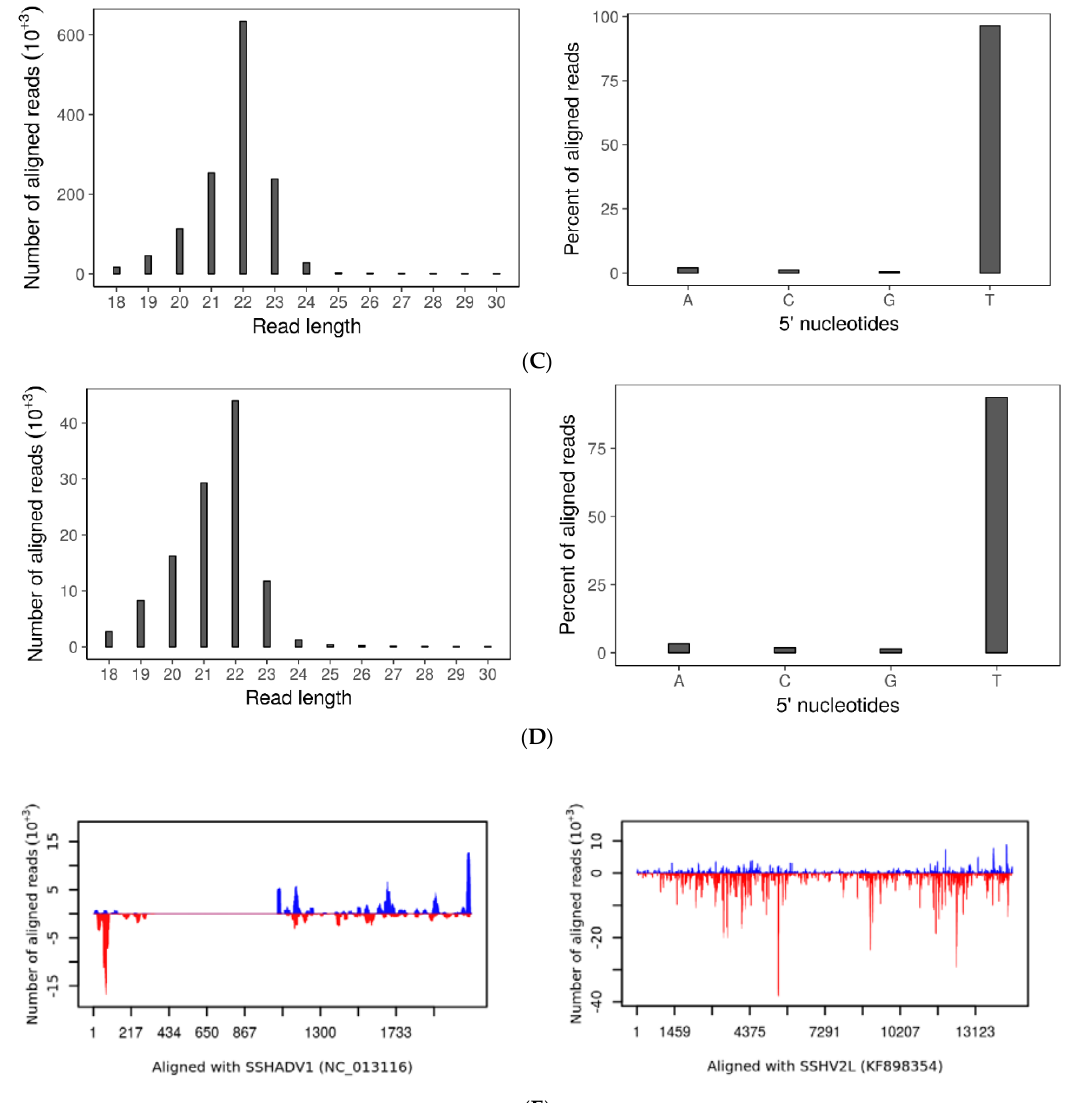
Figure 4. Small RNA: ( A ) Size distribution (left) and frequency of 5’ terminal nucleotides (right) of small RNAs in wtDK3; ( B ) size distribution (left) and frequency of 5’ terminal nucleotides (right) of small RNAs in ∆dcl-1 / dcl-2 disruption mutant; ( C ) size distribution (left) and frequency of 5’ terminal nucleotides (right) of small RNAs aligned to SsHV2-L genome; ( D ) size distribution (left) and frequency of 5’ terminal nucleotides (right) of small RNAs aligned to SsHADV-1 genome; and ( E ) distribution of small RNA reads that aligned to the SsHADV-1 genome plus or minus strands (left) and distribution of small RNA reads that aligned to the SsHV2-L genome plus or minus strands (right). Bars above zero indicate alignment to the positive strand, and bars below zero indicate alignment to the negative strand.